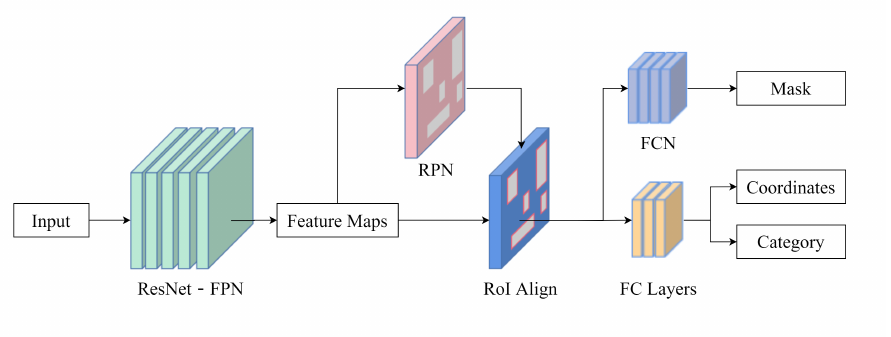
Figure 8. Diagram of Mask R-CNN